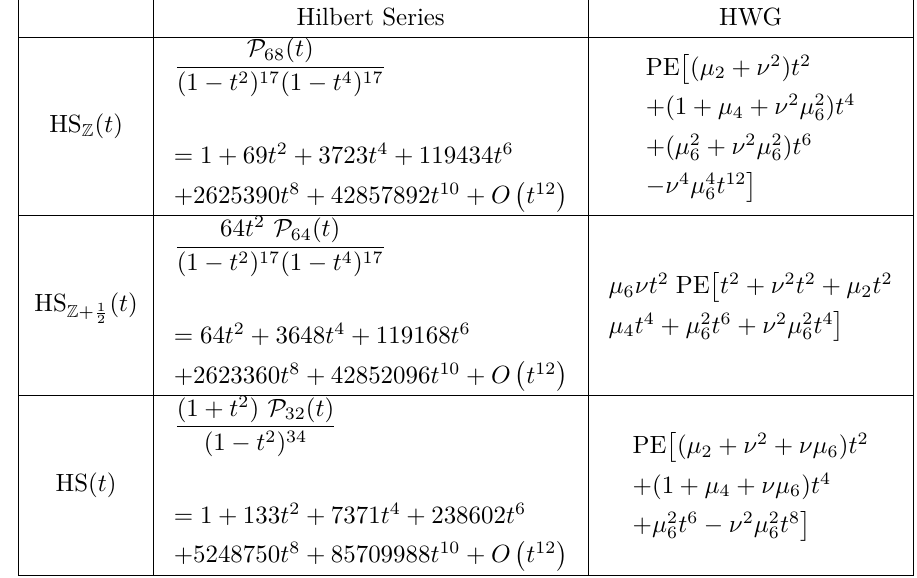
Table 8. Hilbert series for the E 7 magnetic quiver (3.4). The first line of the table provides the Hilbert series when the GNO magnetic lattice is integer HS Z ( t ) , the second line shows the sum over the integers-plus-half lattice HS Z ( t ) and the last line is their sum HS( t ) . The palindromic + 1 2 numerator terms P k ( t ) are given in appendix E. In the third column, we show the HWG in terms of fugacities for su (2) and so (12) (denoted ν and µ 1 , . . . , µ 6 respectively). Note that we pick